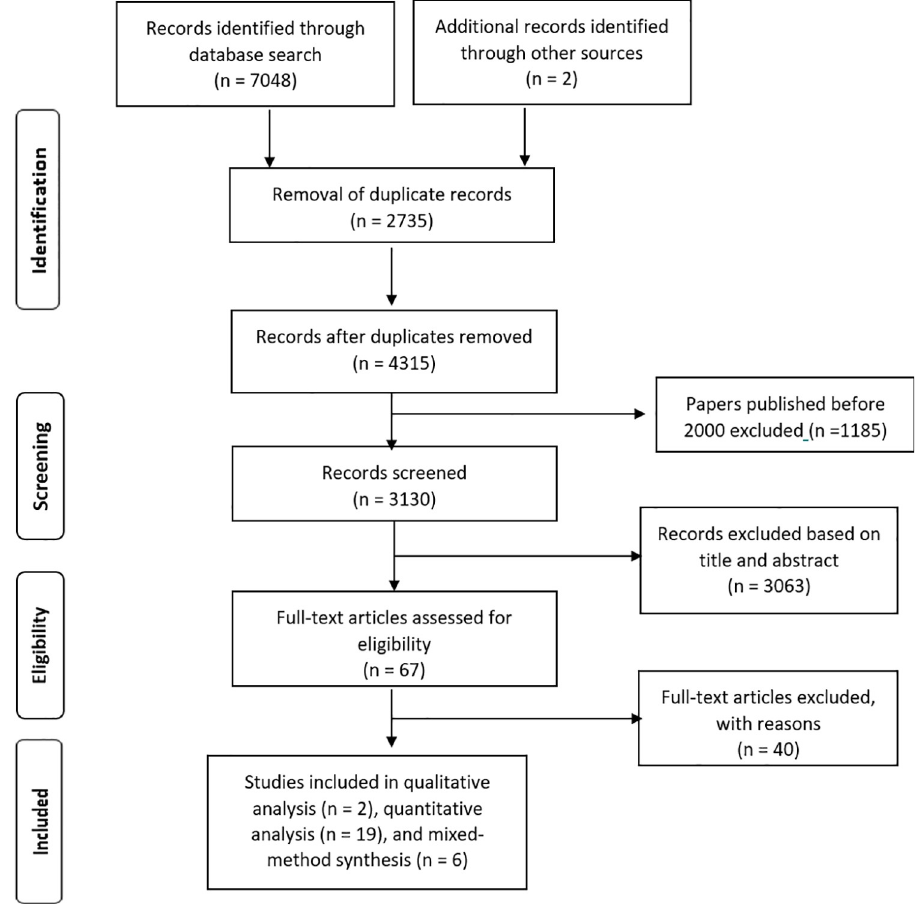
Fig 1. Flow diagram of paper selection